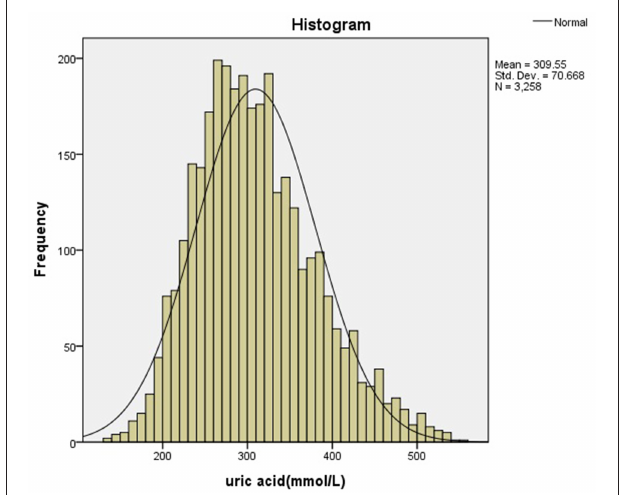
FIGURE 2 | The distribution of uric acid in males.